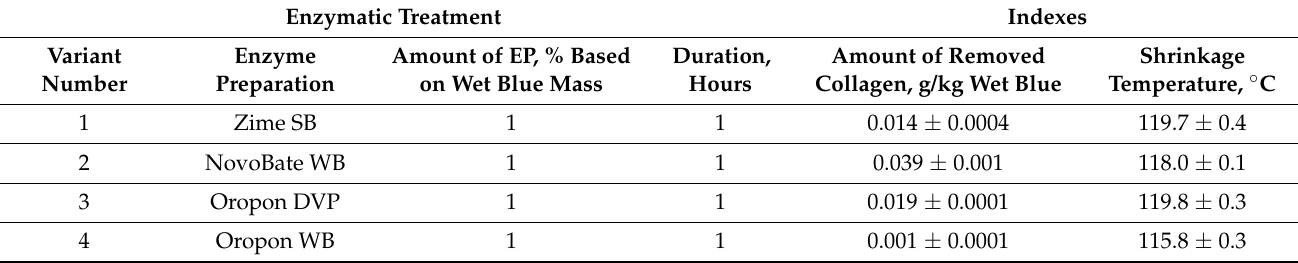
Table 3. EP influence on the amount of collagen in the solution and shrinkage